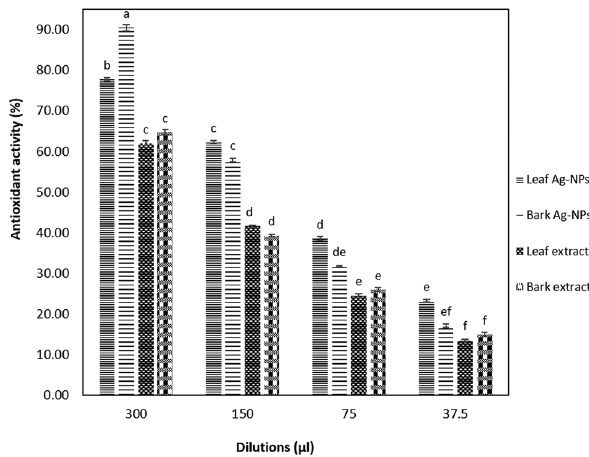
Figure 10: Antioxidant activity of Ag - NPs and plant